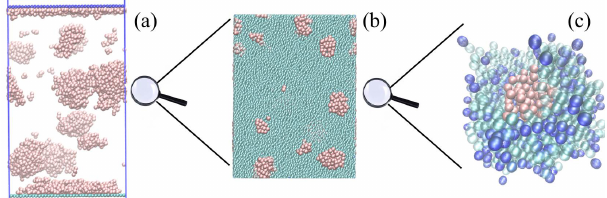
Figure 1. Configuration snapshots of a gel–oligomer system (CGMD) undergoing phase separation at different scales of resolution. ( a ) shows the simulation box with oligomers droplets (pink), while ( b ) shows a magnified region of oligomer droplets (pink) in a gel-matrix (green); ( c ) shows an oligomer droplet (pink beads) trapped within a mesh of an end-linked gel formed by polymers (green beads) with permanently stuck end groups (blue